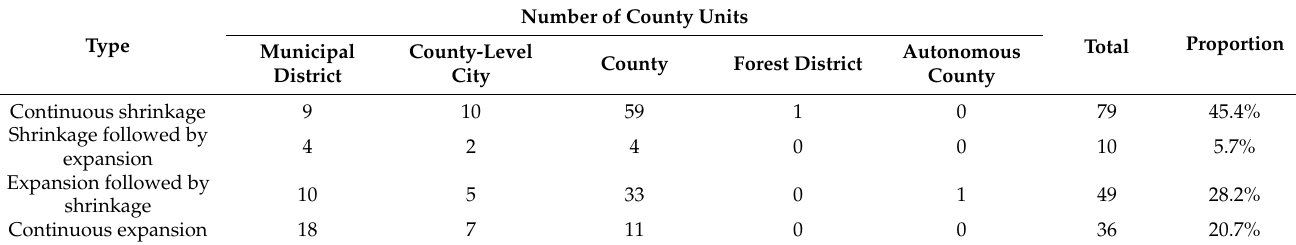
Table 3. Typological characteristics of county population